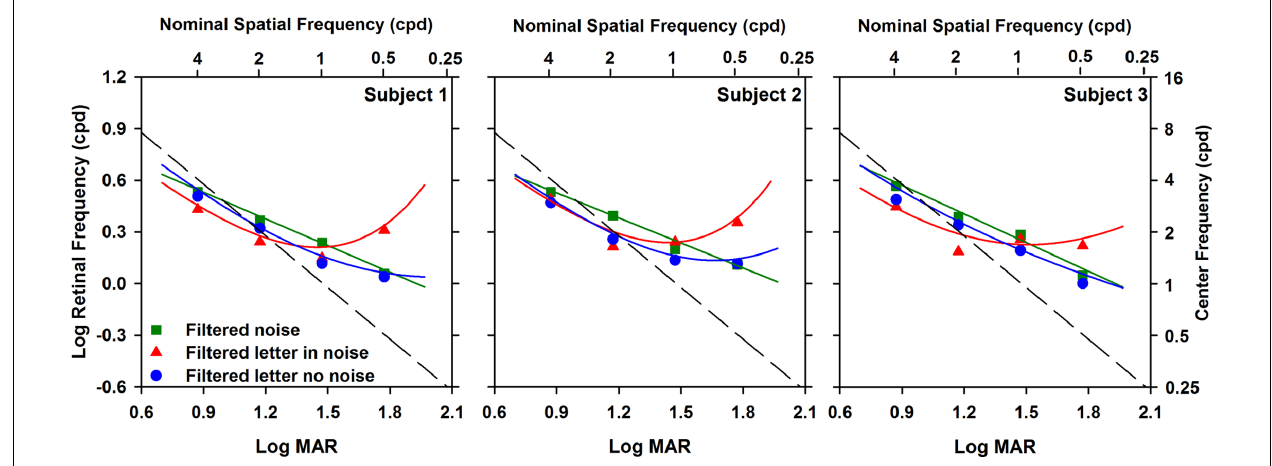
FIGURE 5 | Log retinal frequency (cycles per degree) as a function of log MAR letter size. Data are shown for each subject individually.The data and fits are replotted from Figure 3 in terms of retinal frequency, as described in the text.The dashed line represents the standard assumption that 30 cpd is equivalent to 0 log